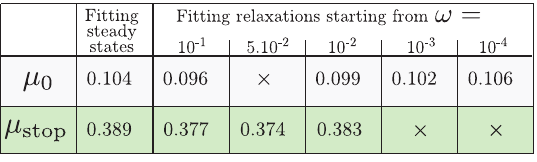
FIG. 7. Values of tan θ when the flow stops for frictionless (top, ½ NaCl (cid:3) ¼ 10 − 6 mol · L − 1 ) and frictional (bottom, ½ NaCl (cid:3) ¼ 10 − 1 mol · L − 1 ) particles (silica spheres of diameter d ¼ 23 . 46 (cid:2) ¼ 1850 kg · m − 3 ). The first column is ob- 1 . 06 μ m and density ρ p tained by fitting the data in steady rotations using a power law with a threshold. The other columns correspond to the angles measured at the end of the relaxations for different initial steady rotation rates.